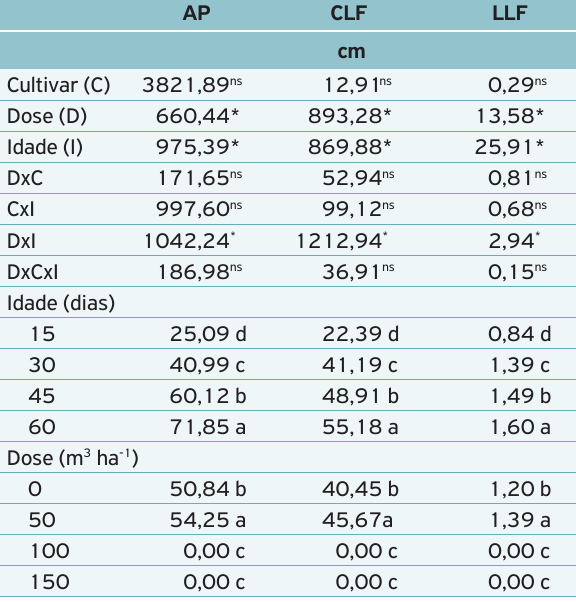
Tabela 1. Análise de variância e valores médios da altura de planta, comprimento e largura da lâmina foliar de cultivares de Brachiaria brizantha sp. submetidos a diferentes doses de biofetilizante de aves.